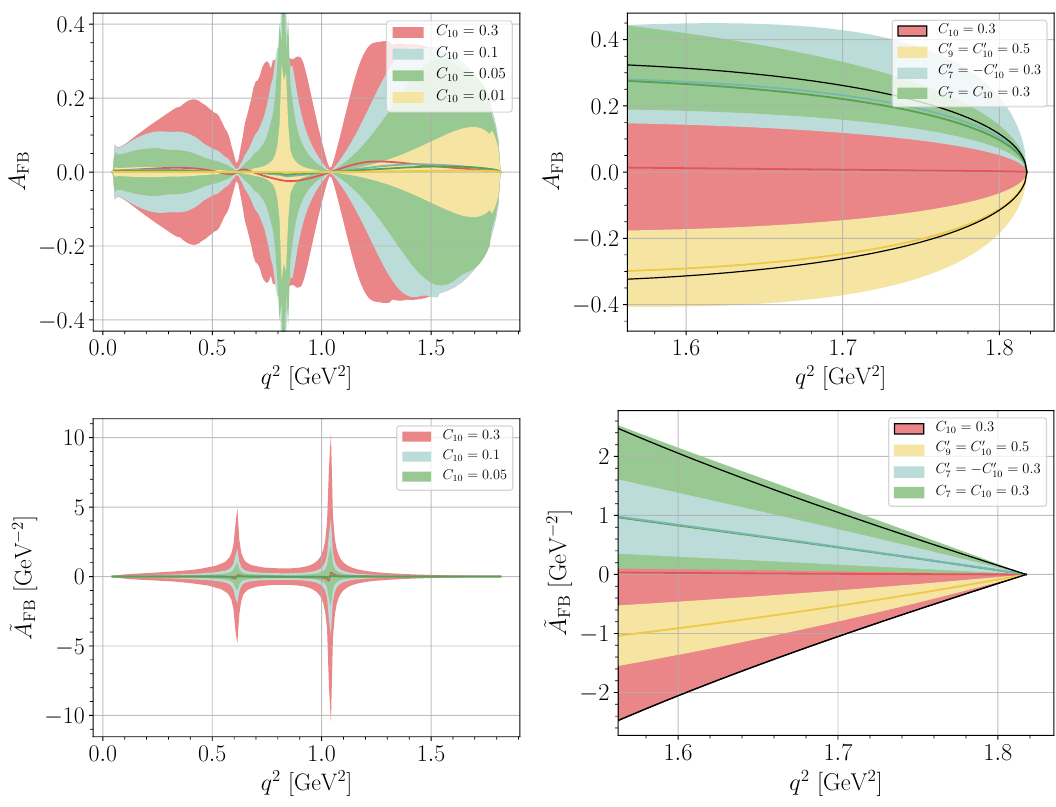
Figure 3 . The forward-backward asymmetry A FB (4.1) (top) and with normalization to the decay rate ˜ A (4.5) (bottom) of Λ + µ − decays for different values of C FB c → pµ panel) and for various BSM contributions in the high q 2 region (right panel), see